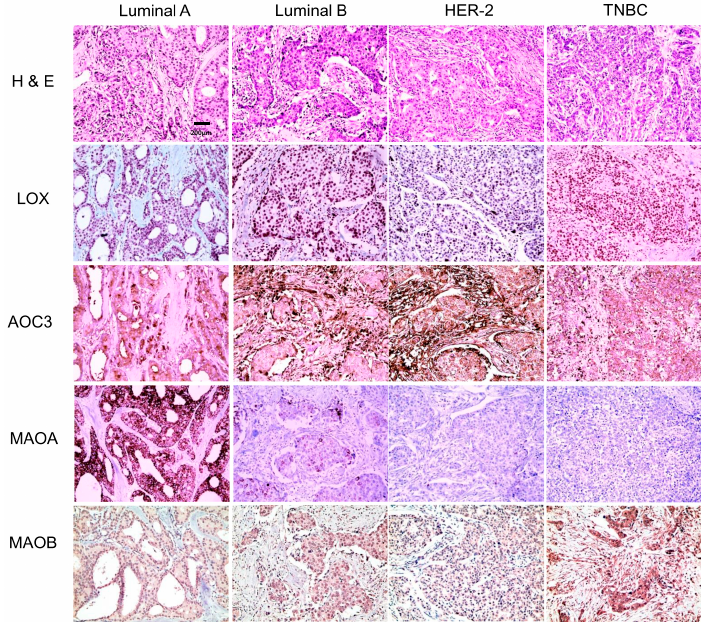
Figure 2. Differential expression of amine oxidase in different tumor subtypes. The expression of stromal AOC3, MAO-A, and MAO-B; high expression of stromal AOC3 in luminal B and HER-2-type breast cancers; and high MAO-A expression in luminal A and luminal B ( p < 0.001). MAO-B expression was higher in TNBC than that in other proteins ( p = 0.020).